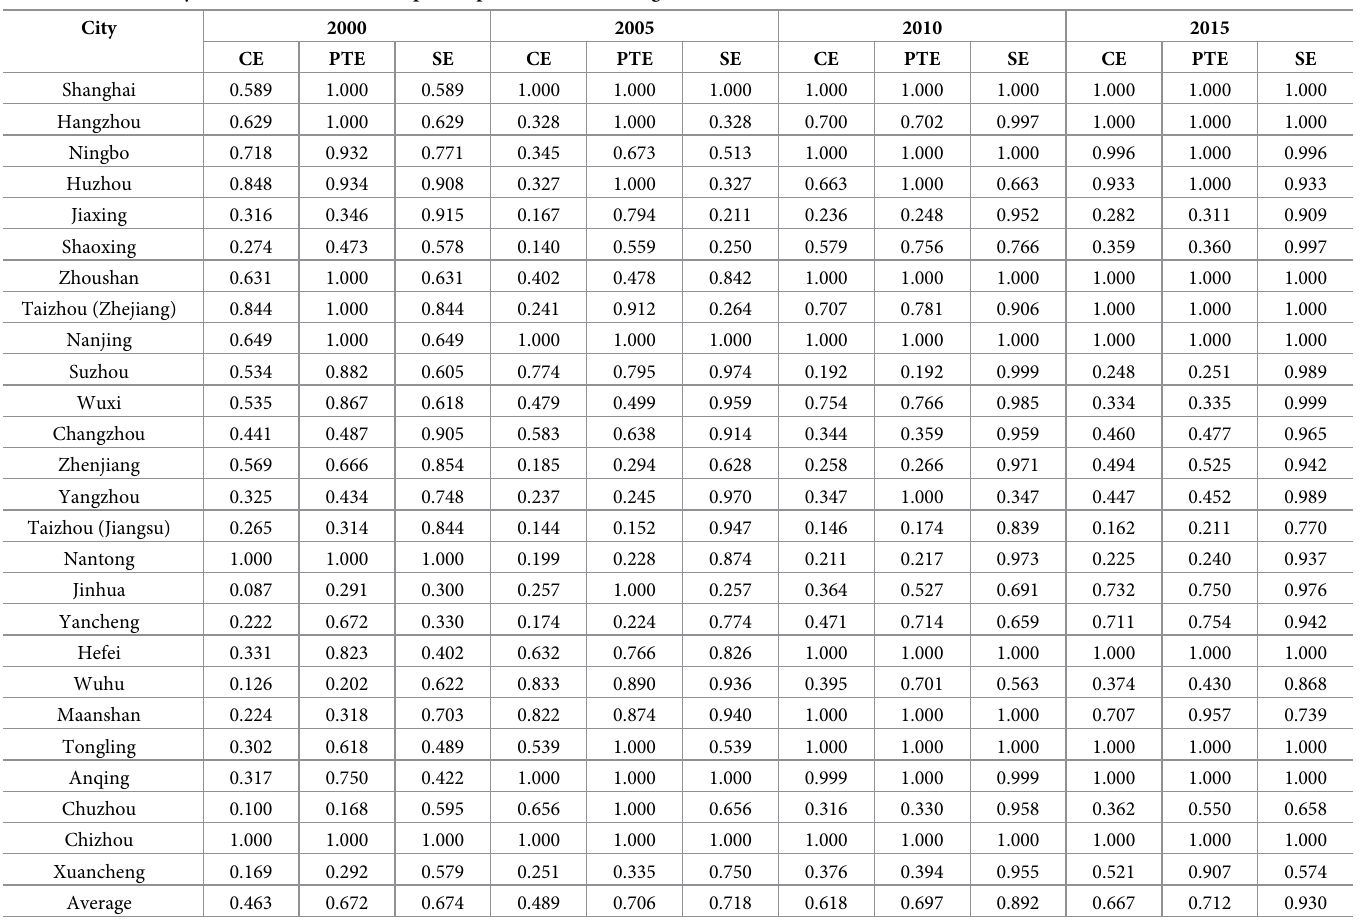
Table 2. The efficiency of innovation resources input-output of YRDUA during